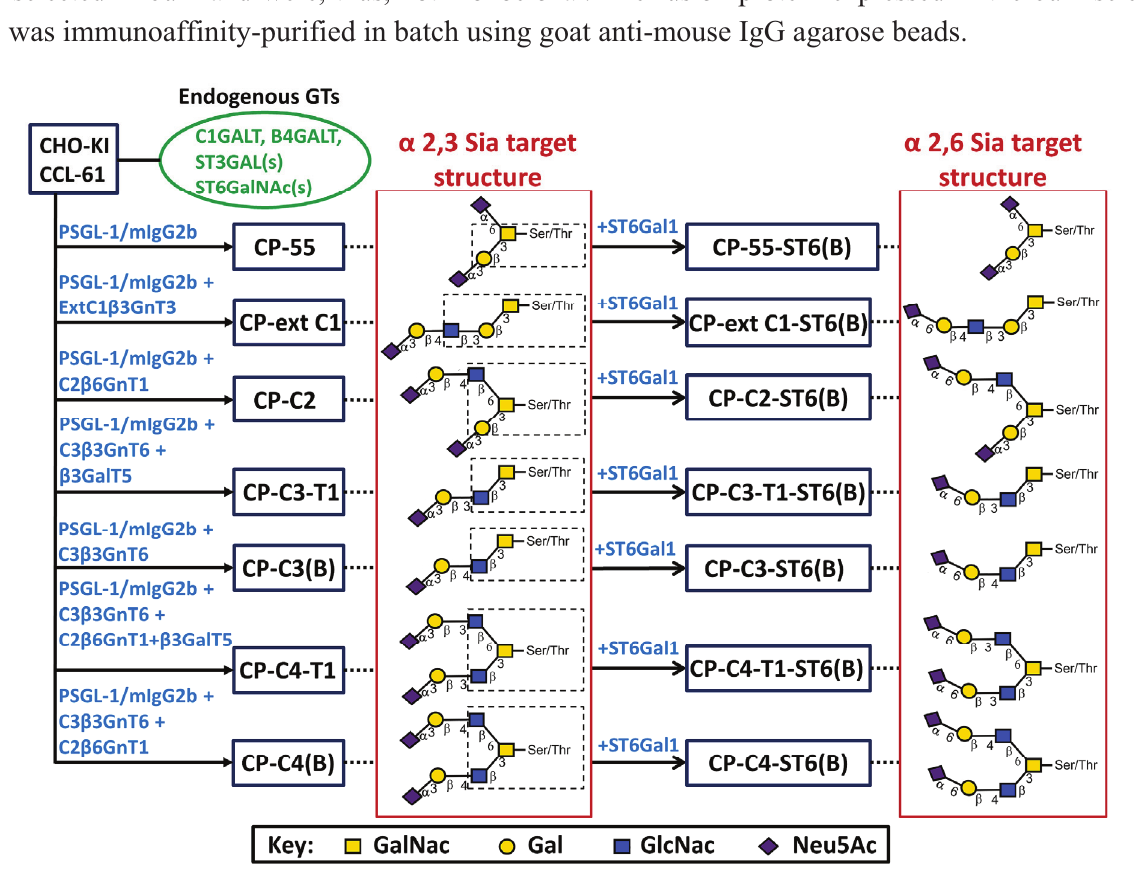
Figure 1. Stable CHO transfection scheme with designations of cell clones or bulk-selected cell populations and their respective target structures. CHO-K1 cells with their endogenous glycosylation machinery (green, oval box) were stably transfected with P-selectin glycoprotein ligand-1/mouse IgG2b Fc and O -glycan core chain glycosyltransferase cDNAs (blue) to generate stable CHO cell lines (blue boxes). In the name designation, C stands for CHO-K1, P for PSGL-1/mIgG2b, followed by the expected O -glycan core structures and (B) denotes bulk-selected cell populations. Based on the known specificity of the glycosyltransferases expressed, each cell line was expected to generate, among others, the indicated target structures (dotted line) based on different O -glycan core saccharide chains (dotted box). The O -glycan core structures were elongated by expressing B3GALT5 or by action of the endogenous B4GALTs to form type 1 or 2 outer chains, respectively. Terminal (cid:2)2,3- or (cid:2)2,6-sialylation was seen following the activity of a CHO-endogenous ST3GAL(s) or expression of β -galactoside (cid:2)2,6-sialyltransferase 1